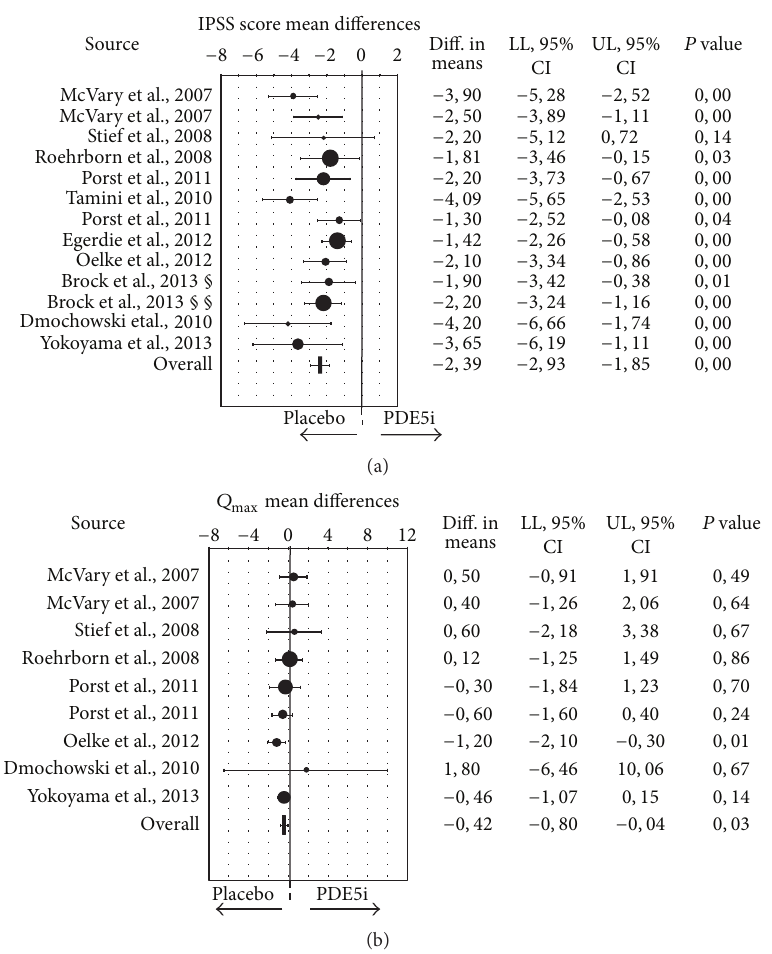
Figure 3: Weighted differences (with 95% confidence interval (CI)) of International Prostate Symptom Score (IPSS; (a)) and maximum flow rate ( 𝑄 max ; (b)), for the studies on phosphodiesterase type 5 inhibitors (PDE5-Is) versus placebo. § no erectile dysfunction; §§ erectile